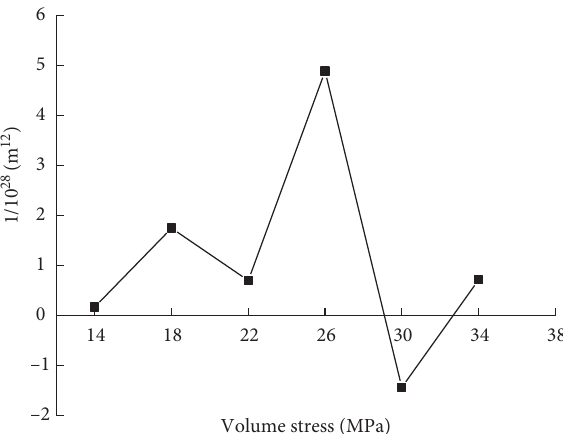
Figure 8: The curve of β factor versus volume stress.